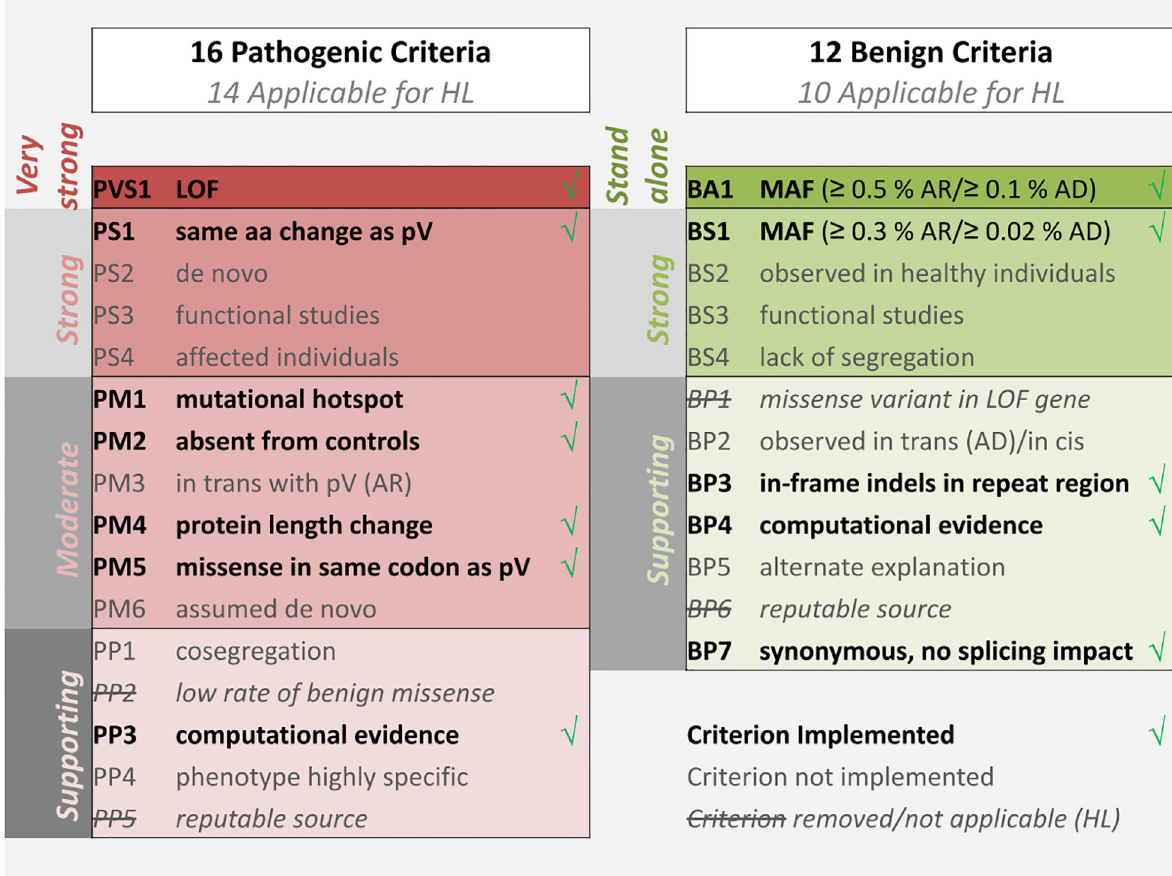
PLOS Computational Biology | https://doi.org/10.1371/journal.pcbi.1009785 September 21,